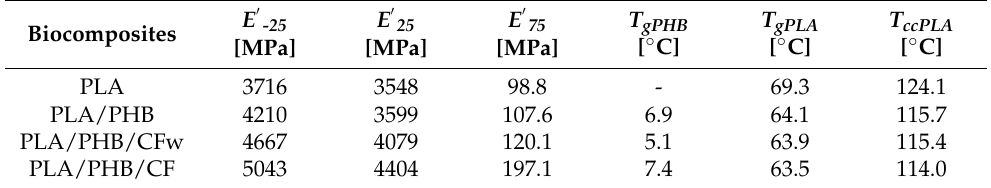
Table 4. Characteristics of PLA and PLA/PHB biocomposites from DMA